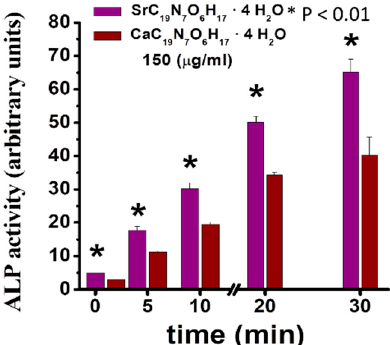
Figure 3. Alkaline phosphatase (ALP) expression in human osteoblasts cultured in the presence of Sr and Ca folic acid derivatives. Figure adapted from Rojo et al. [18] with permission from the Royal society for Chemistry. Molecules 2019 , 24 , x FOR PEER REVIEW